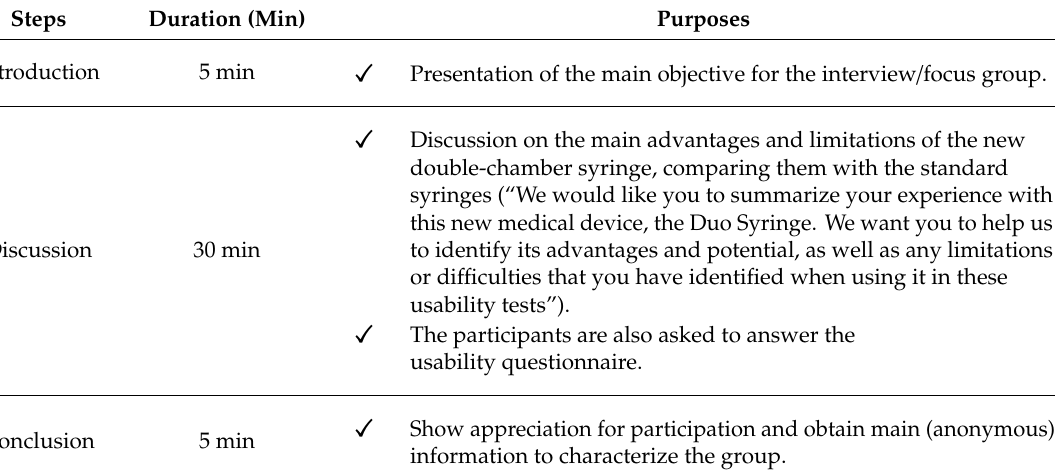
Table 2. Interviews and focus groups